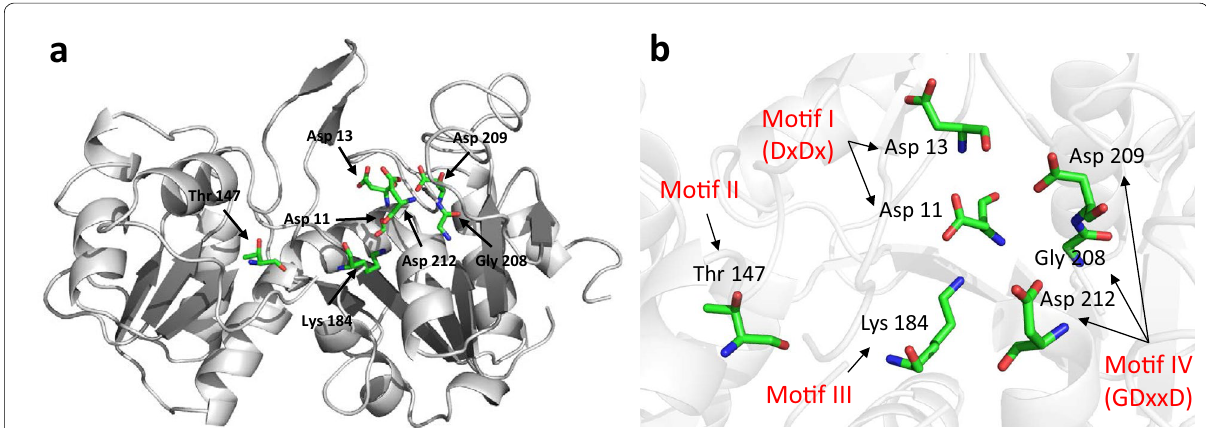
Fig. 1 Crystal structure of probable p -nitrophenyl phosphatase from Archaeoglobus fulgidus (AfPase, PDB 4jdp). Cartoon representations of the structure of the fold with close-up of different active site configurations. Beta strands are colored dark gray, while alpha-helices are colored light gray. a Side view of AfPase. It shows the Rossmann-like fold of the HAD superfamily and reveals the typical spatial orientations of the conserved residues involved in catalysis. b Close-up active site view of AfPase with motif I–IV signatures. Motif I: conserved amino-acid sequence of DxDx, Motif II: conserved amino-acid of Thr or Ser, Motif III: conserved amino acid of Arg or Lys, Motif IV: conserved amino-acid sequence of (G/S)(D/S)x 2–6 (D/N)